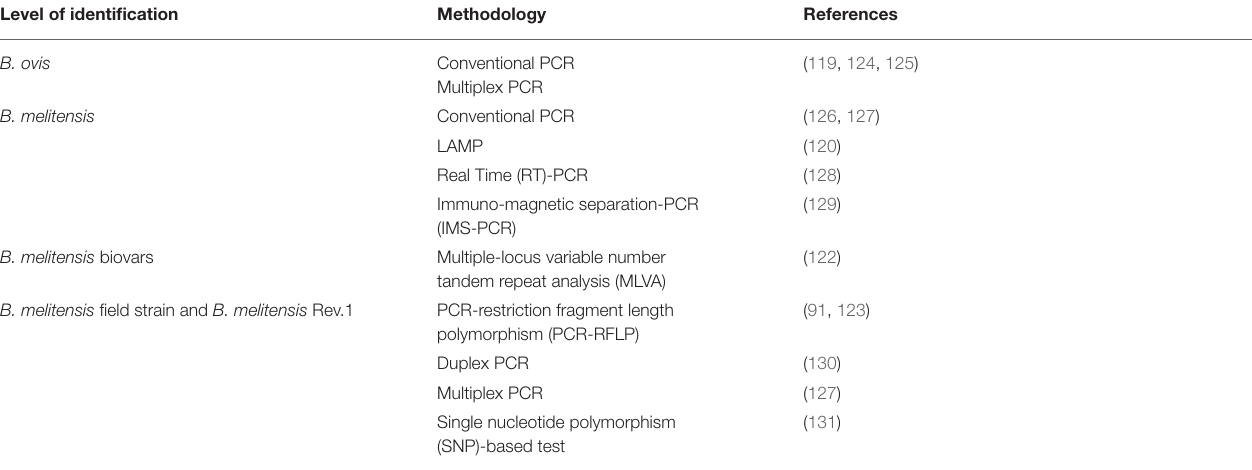
TABLE 4 | PCR-based methods for B. melitensis and B. ovis specific